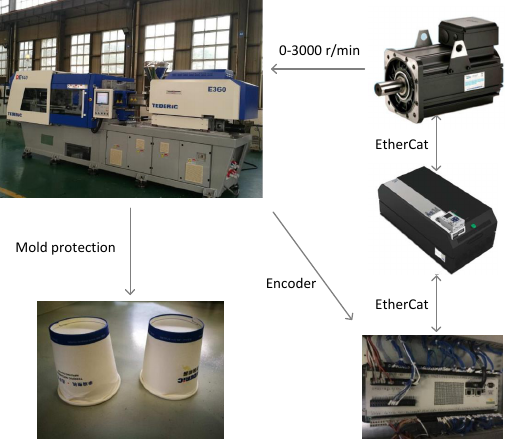
Figure 6. Experimental facility, control process, and effect of MP